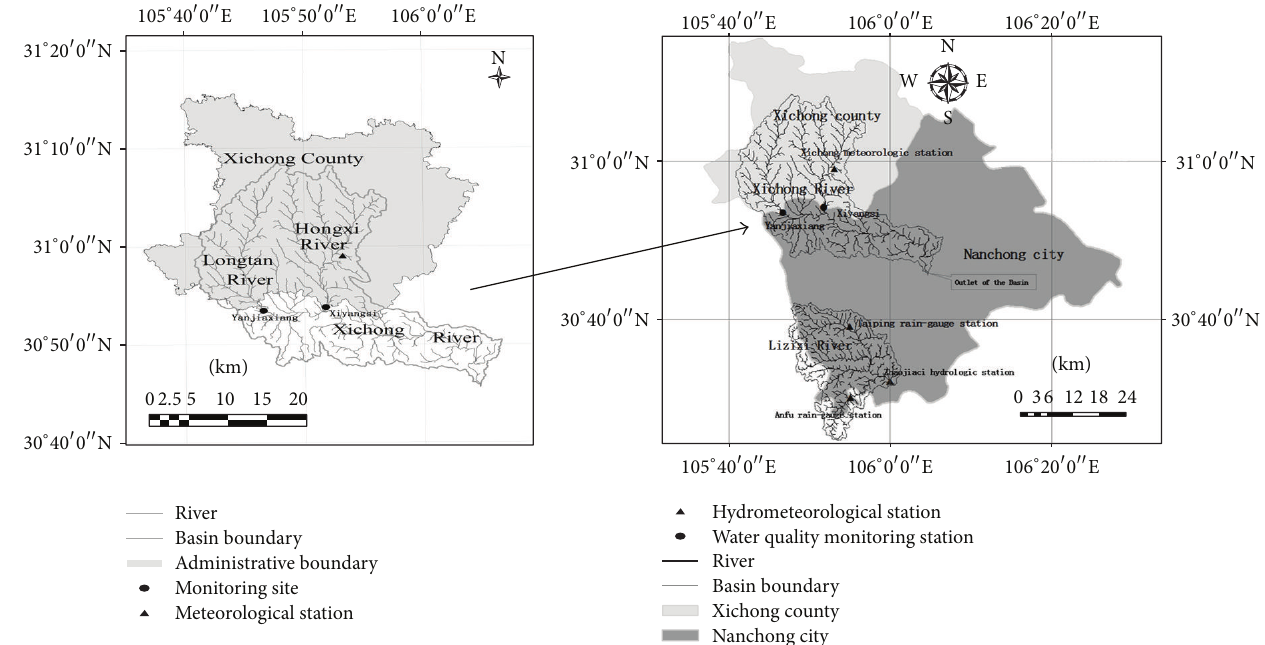
Figure 1: Stream network, division of influence regions, and the distribution of